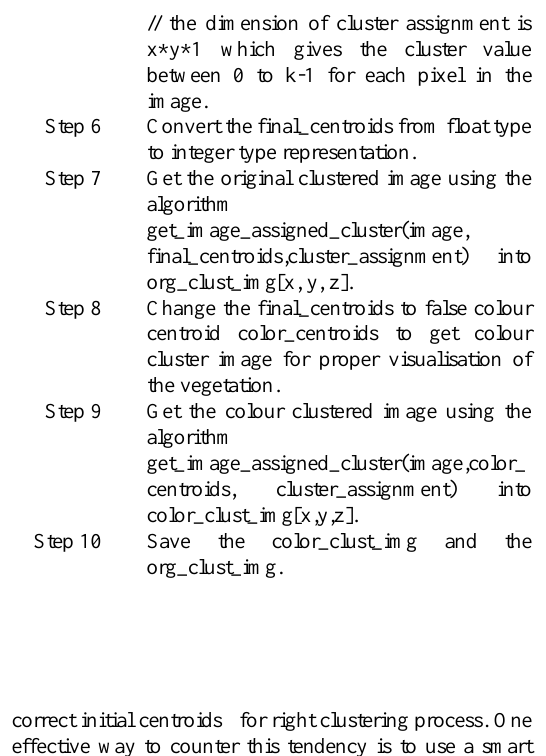
Algorithm 1. Clustering process (image[x, y, z])